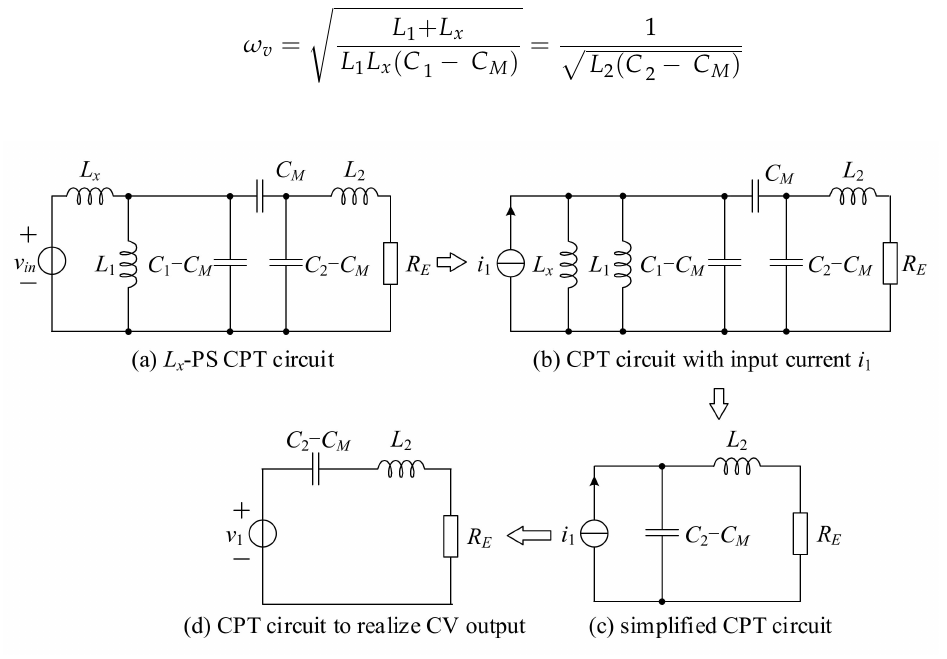
Figure 6. The L x -PS CPT circuit using the Π -type model to realize constant voltage (CV)